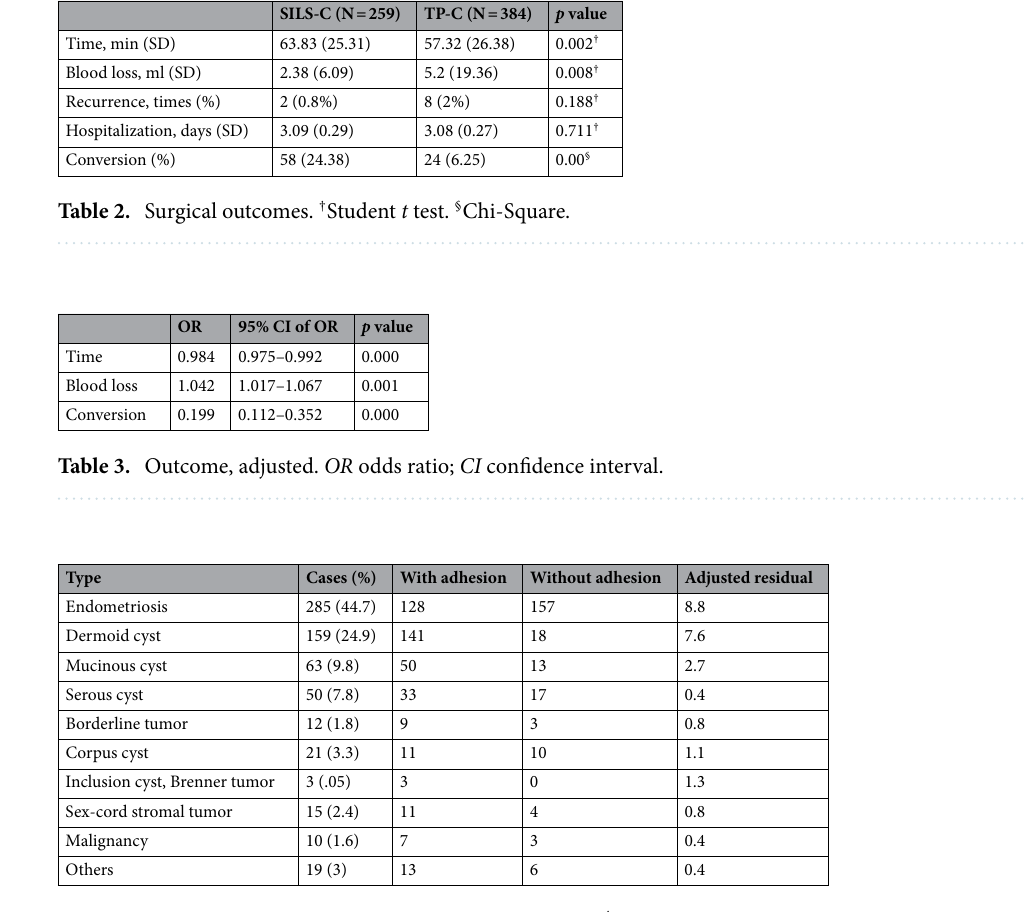
Table 4. Pathology and its association with pelvic adhesion. ‡ The adjusted standardized residual. If the value is greater than 2, it indicates the proportion is significantly different at p < 0.05